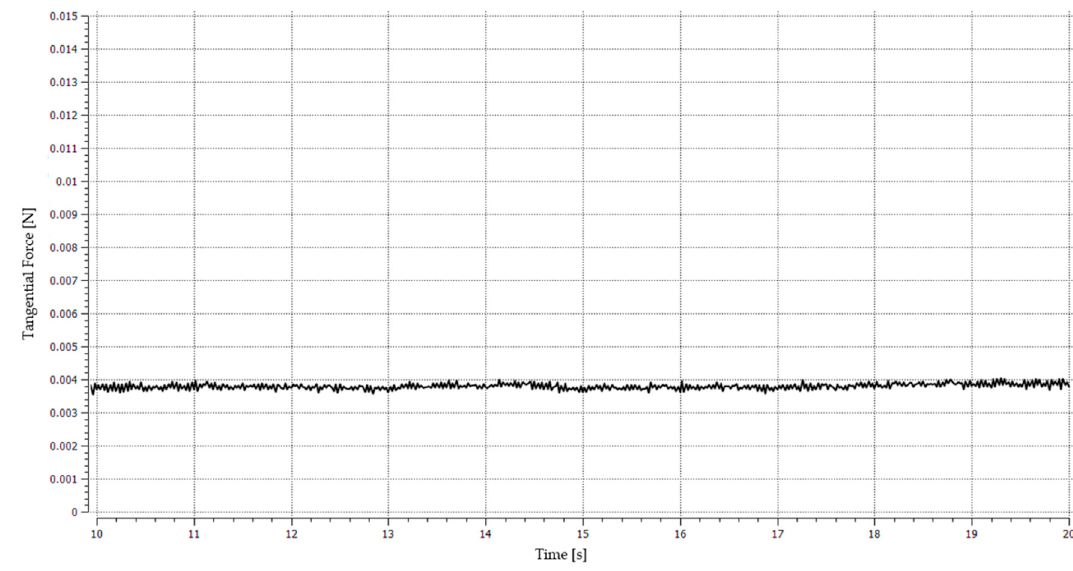
Figure 11. Average forces acting on the fruit in the tangential direction reciprocating transport.